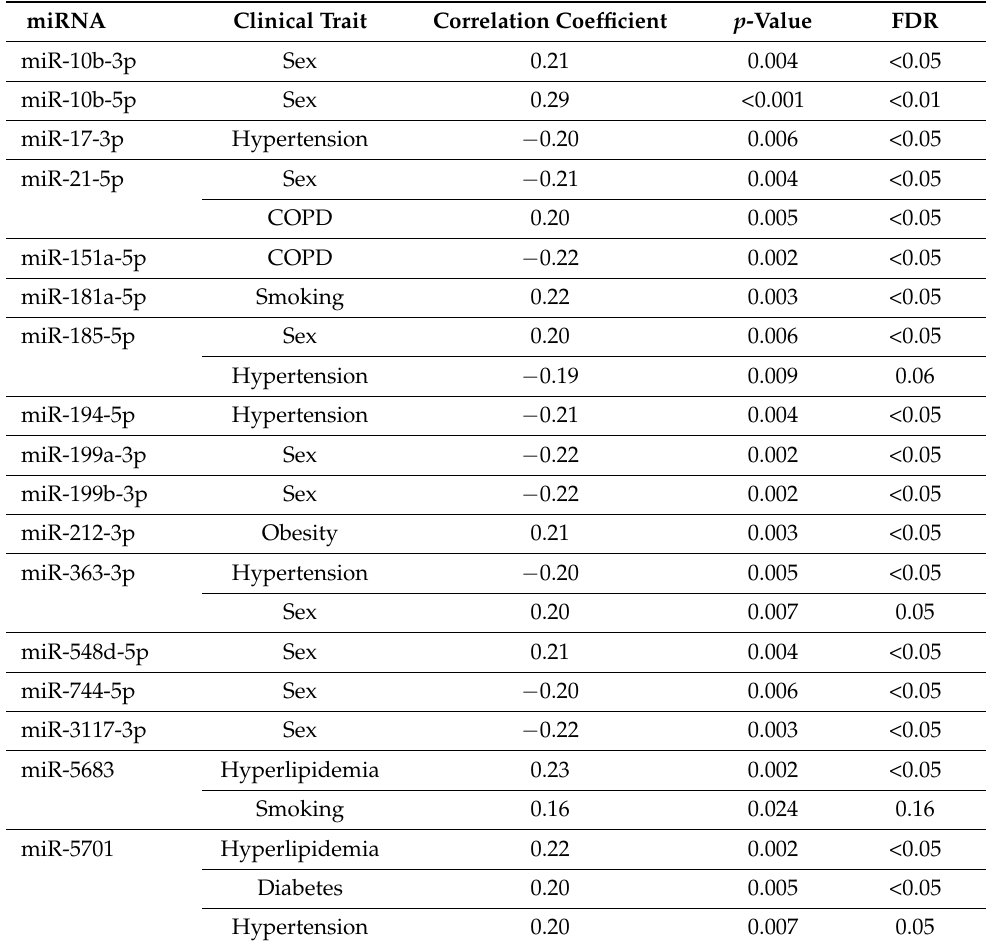
Table 2. 17 miRs significantly correlated to at least one cardiovascular risk factor (clinical trait). Shown are correlation coefficients, adjusted p -values and false discovery rate (FDR). For miRs correlated to several clinical traits of interest correlation coefficients above 0.15 are provided. miRNA Clinical Trait Correlation Coefficient p -Value FDR miR-10b-3p Sex 0.21 0.004 <0.05 miR-10b-5p Sex 0.29 <0.001 <0.01 miR-17-3p Hypertension − 0.20 0.006 <0.05 miR-21-5p Sex − 0.21 0.004 <0.05 0.20 0.005 <0.05 COPD − 0.22 0.002 <0.05 Smoking 0.22 0.003 <0.05 Sex 0.20 0.006 <0.05 − 0.19 0.009 0.06 − 0.21 − 0.22 Sex − 0.22 0.002 0.21 − 0.20 0.005 <0.05 Sex 0.20 Sex 0.21 0.004 Sex − 0.20 0.006 <0.05 Sex − 0.22 0.003 <0.05 0.23 0.002 <0.05 0.16 0.16 0.22 0.002 <0.05 0.20 0.005 <0.05 Hypertension 0.20 0.007 0.05 The heat-map illustrates positive and negative correlation coefficients between miRs and risk factors (Figure 2). 5 miRs were significantly correlated to at least 2 different risk factors. 7 miRs showed positive, 7 miRs showed negative, and 3 miRs showed positive and negative correlation to different risk factors. Most correlations between miRs and risk factors were found to be associated with gender ( n = 10), followed by arterial hypertension ( n = 5), hyperlipidemia ( n = 2), smoking status ( n = 2), chronic lung disease ( n = 2), obesity ( n = 1) and diabetes ( n = 1). The strongest correlation was observed between gender and miR-10b-5p, with significantly higher expression values in women (correlation coefficient 0.29, p < 0.0001, FDR < 0.01). From a clinical perspective most interestingly–as risk factors can be targeted therapeutically–miR-5701 was positively correlated to arterial hypertension, hyperlipidemia and